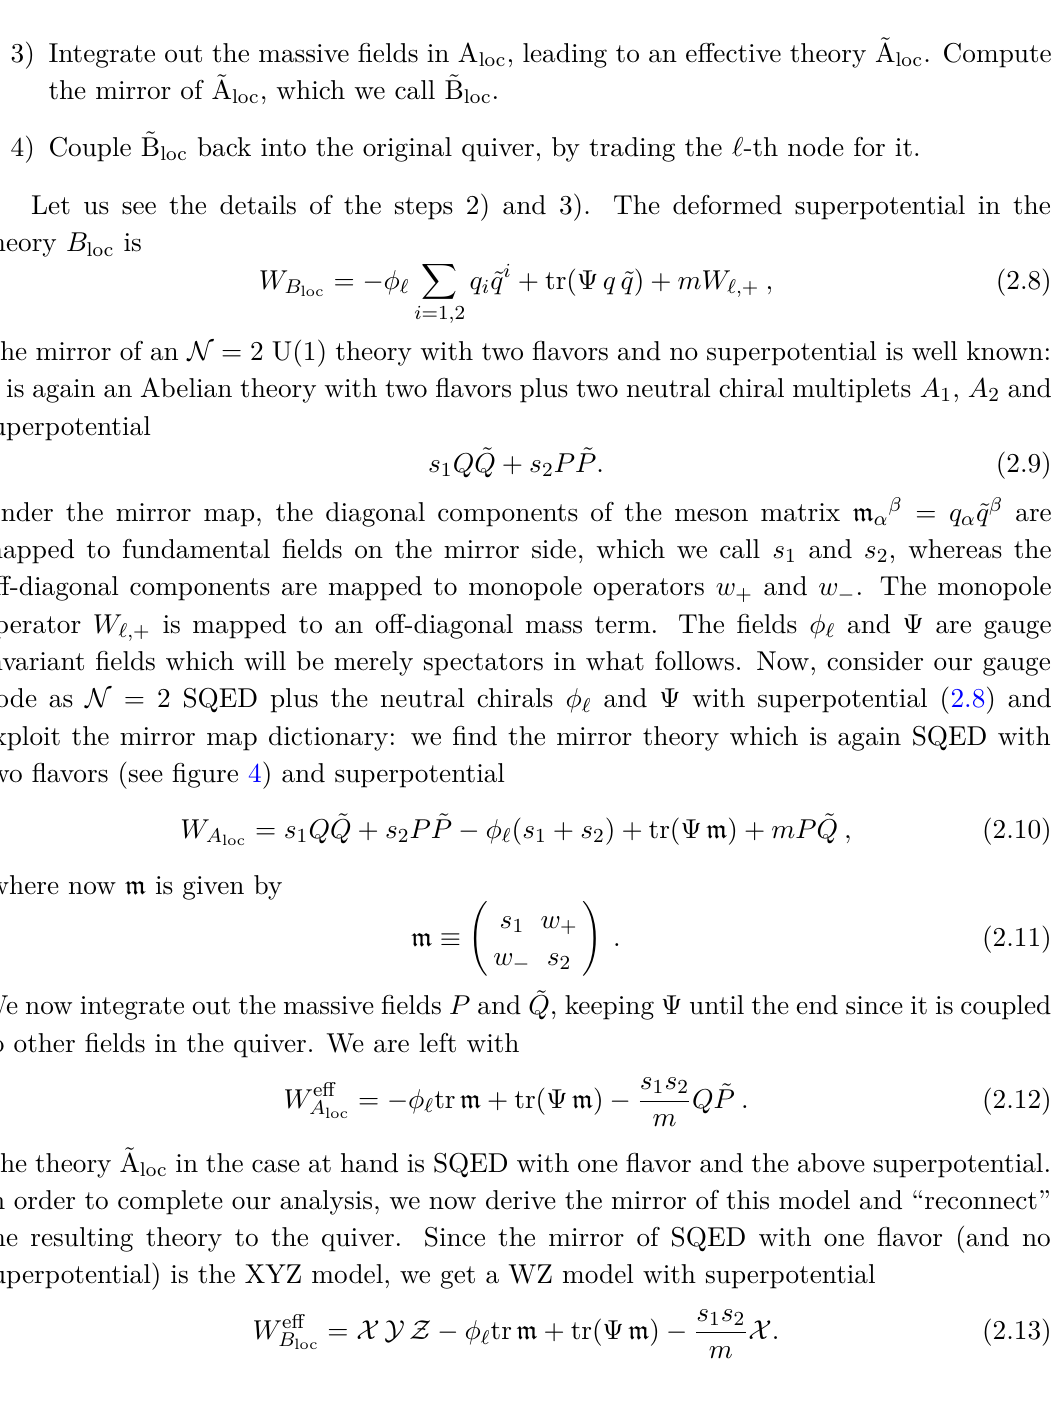
Figure 4 . Theory A loc